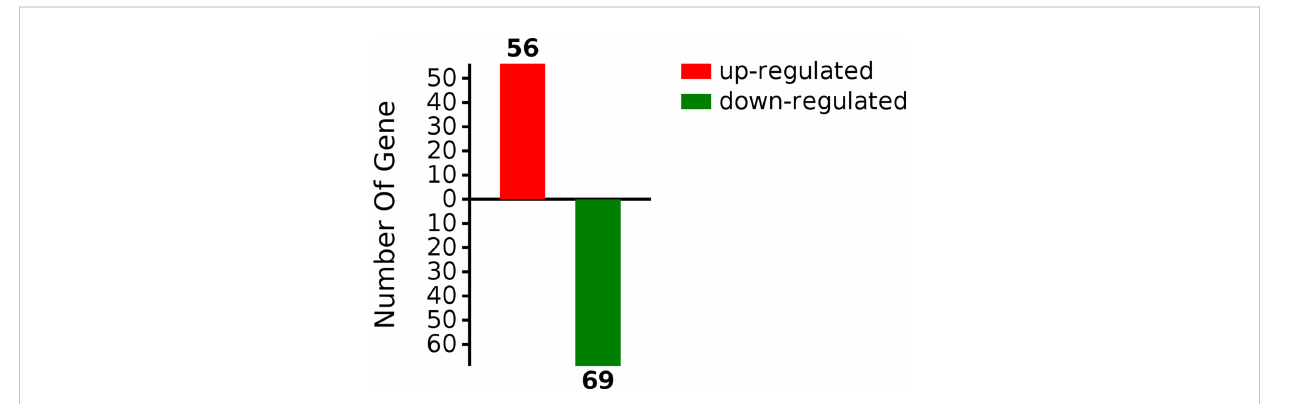
FIGURE 2 Differentially expressed proteins in the liver tissue of HFD- G0S2 overexpression